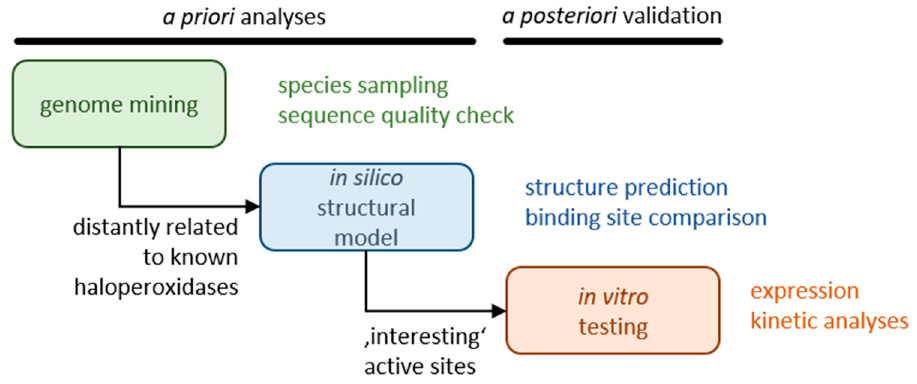
Figure 1. A priori mining approach .